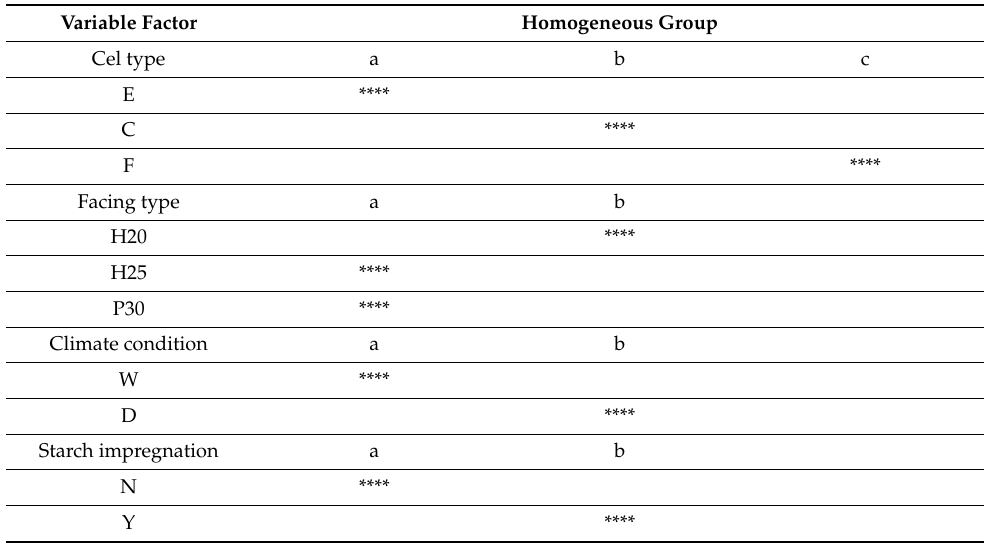
Table 9. Summary of statistically homogeneous groups determined on the basis of the HSD Tukey test for selected variable factors in the research for the direction of orthotropy Y. (The symbol **** meaning that results are not statistically